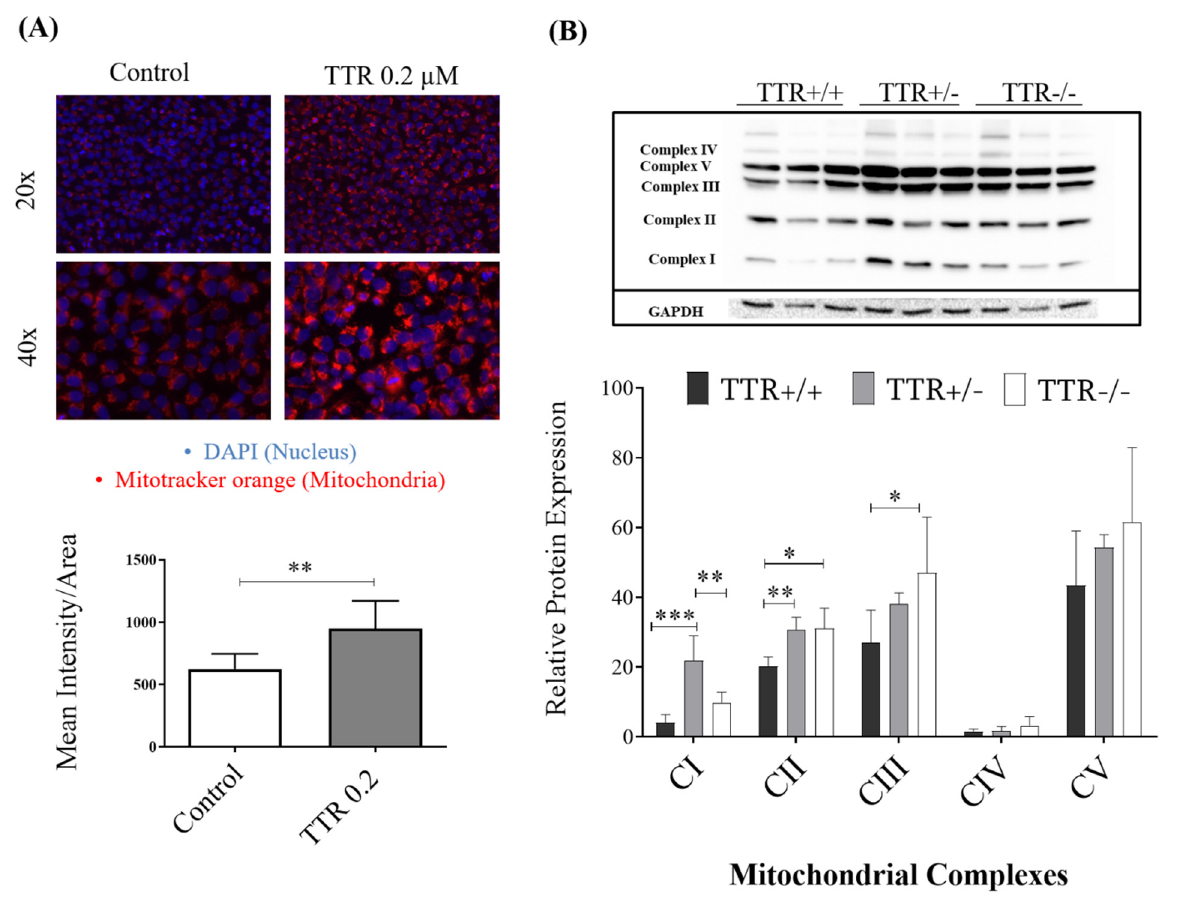
Figure 4. Effect of TTR on mitochondria as assessed by fluorescent microscopy and Western blot. ( A ) HepG2 cells treated with h rTTR showed significantly higher mitochondrial density compared to untreated ones ( N = 5 for each condition). ( B ) In mouse liver, and as assessed by Western blot, higher protein levels of mitochondrial CI and CII were observed in TTR+/ − mice, and higher CII and CIII in TTR − / − mice, compared to TTR+/+ animals ( N = 3 for each genotype). Data are expressed as mean ± SD. Significant results are indicated by * when p < 0.05, ** when p < 0.01, and *** when p < 0.001.